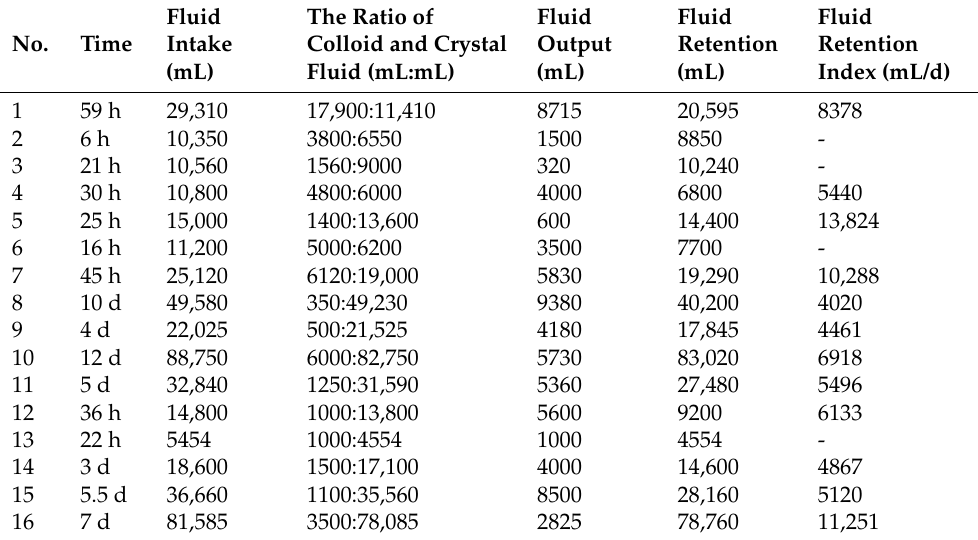
Table 3. IV fluid volumes in the 16 cases of massive fluid infusion.